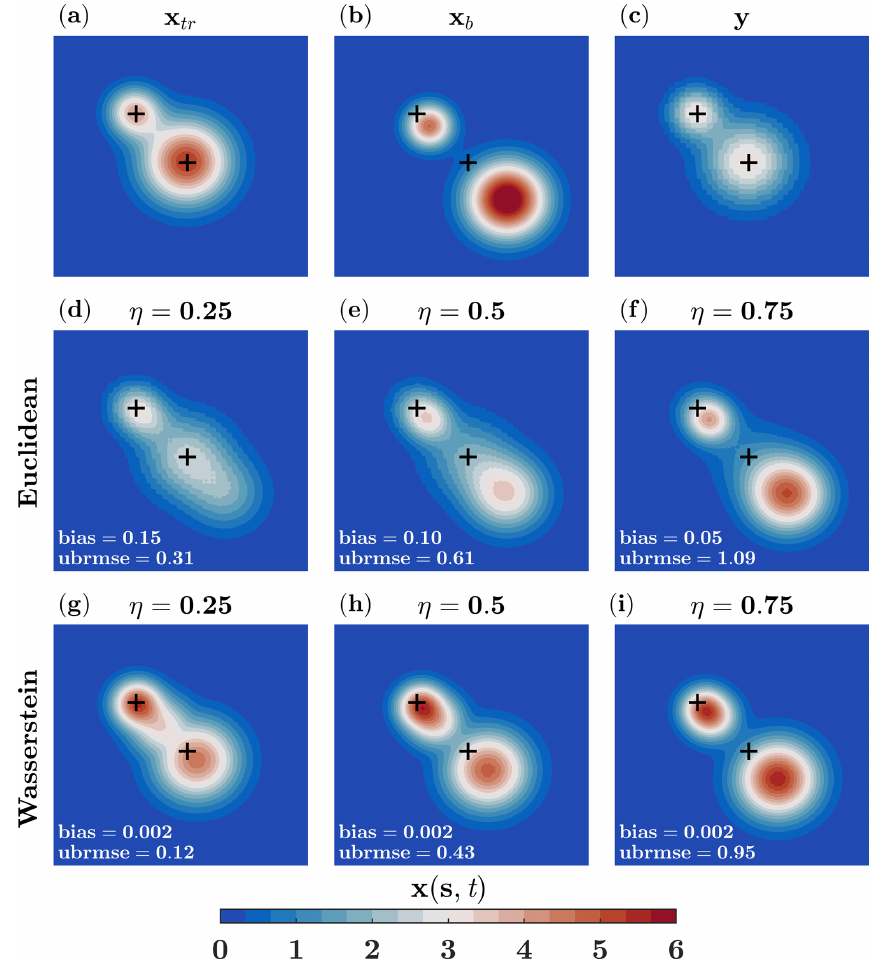
Figure 4. The true state x tr , the background state x b , and observation y (a) – (c) with systematic errors under a 2-D advection–diffusion dynamics, as well as the Euclidean (d) – (f) and the Wasserstein barycenters (g) – (i) , between x b and y for different displacement parameters η . The entropic regularization parameter is set to γ = 0 . 003, and the black plus signs show the location of the modes for the true state.